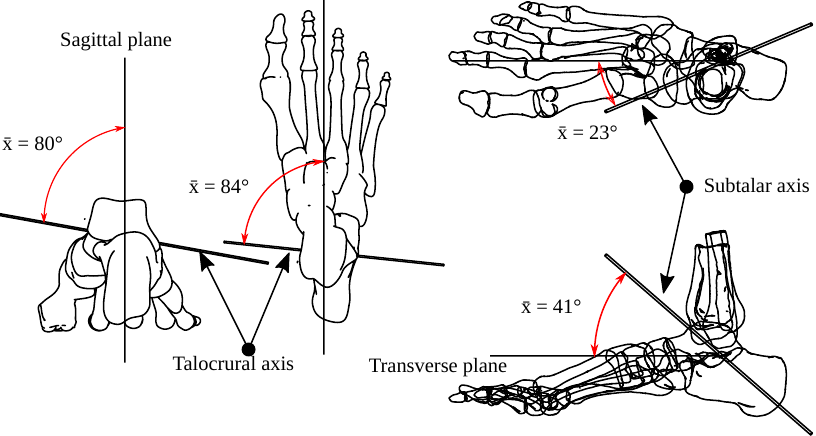
Figure 3. Mean relative position of the ST and TC